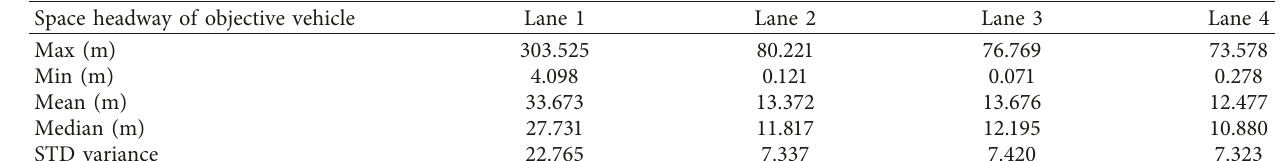
Table 4: Detailed information on the gap of the objective vehicle.